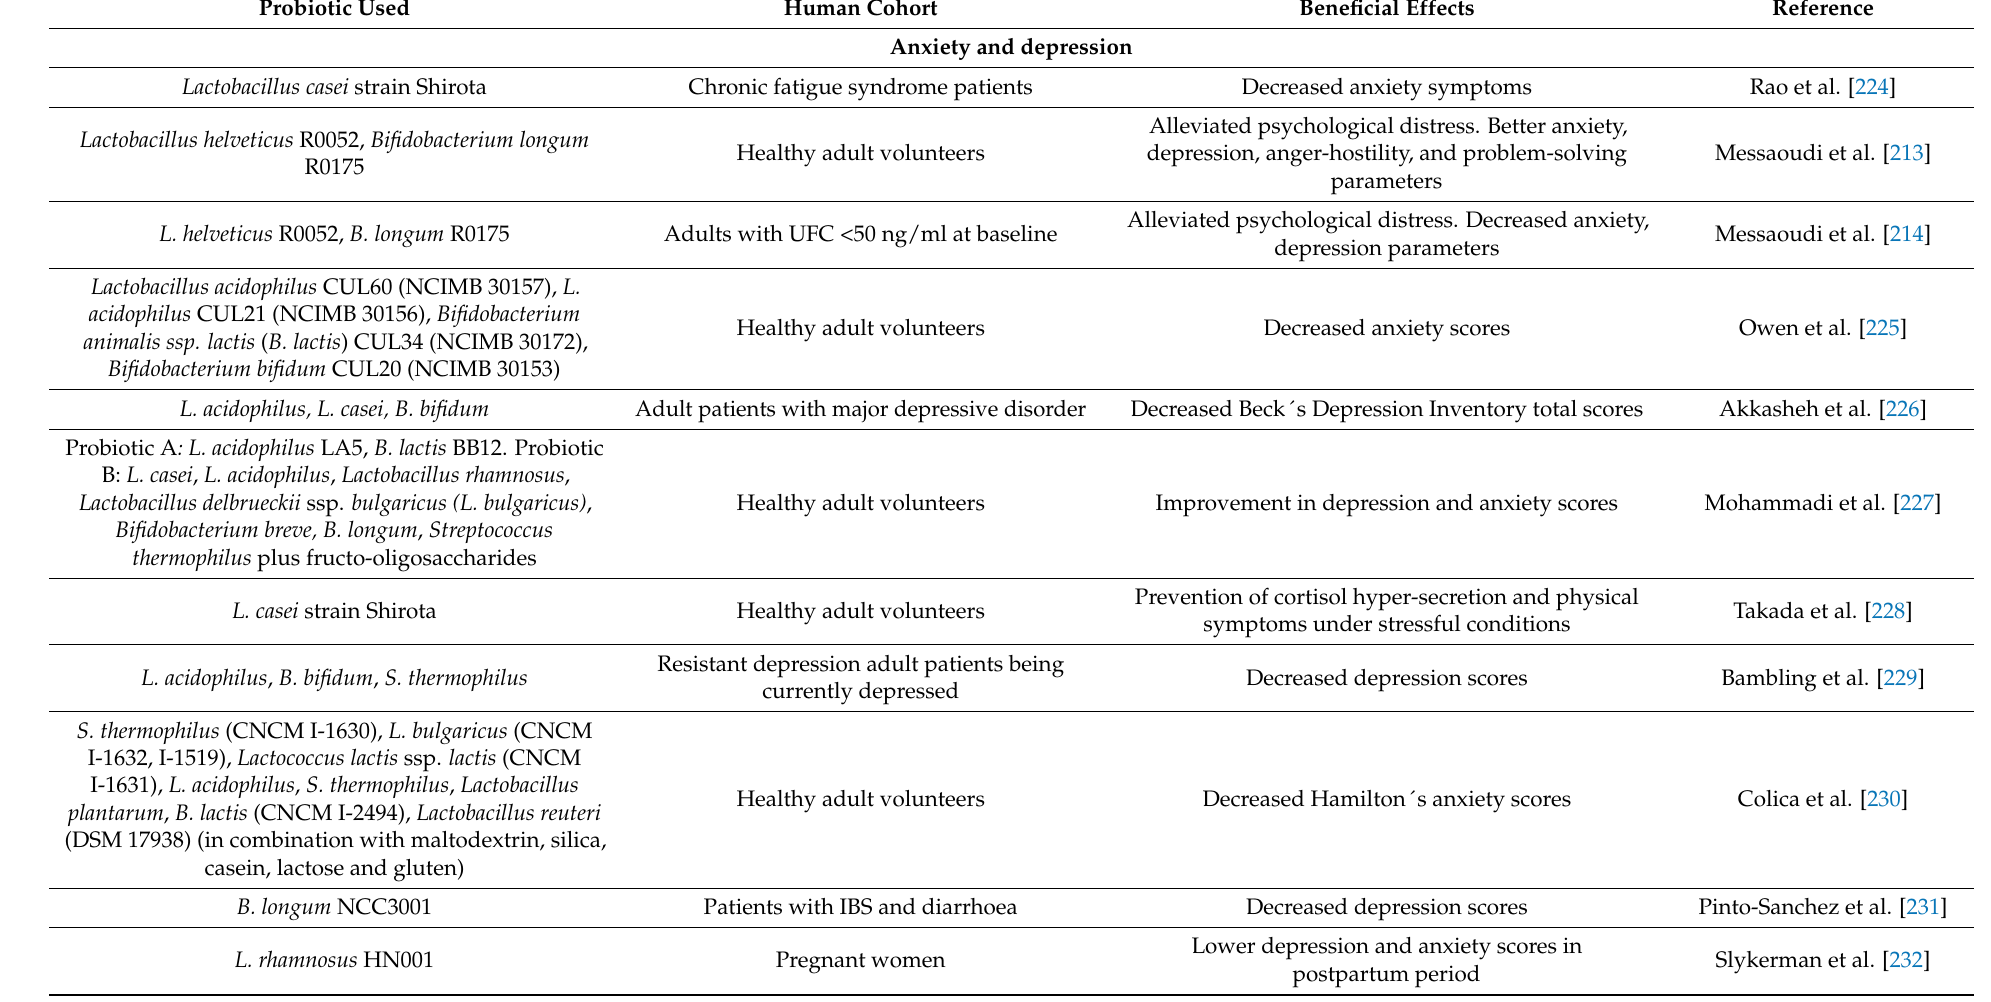
Table 3. Studies evaluating the effects of probiotics on brain